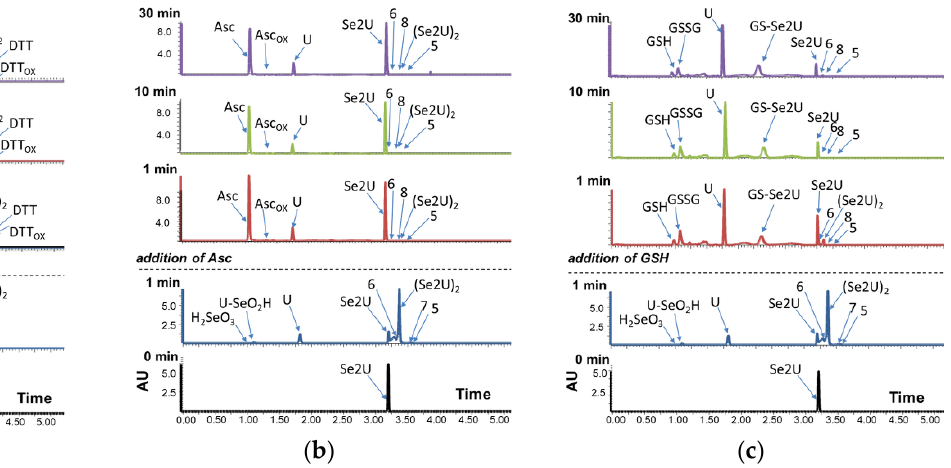
Figure 11. UPLC–PDA chromatographic analysis of the oxidation reaction of Se2U ( 1 , 10 mM) with H 2 O 2 (10 mM) and subsequent rescue by 10 mM reducing agent: ( a ) DTT, ( b ) ascorbic acid (Asc), ( c ) glutathione (GSH) added 1 min after the start of oxidation.